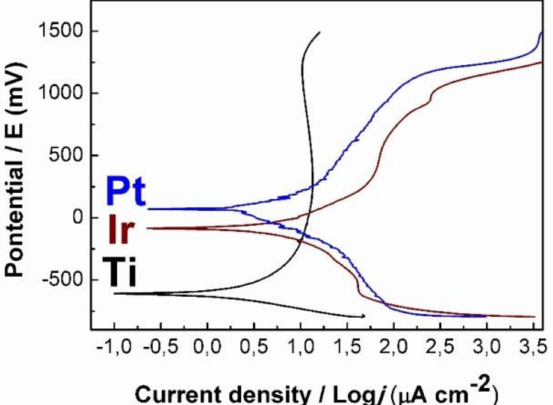
Figure 4. Polarization curves of Ir and Pt samples in comparison with uncoated